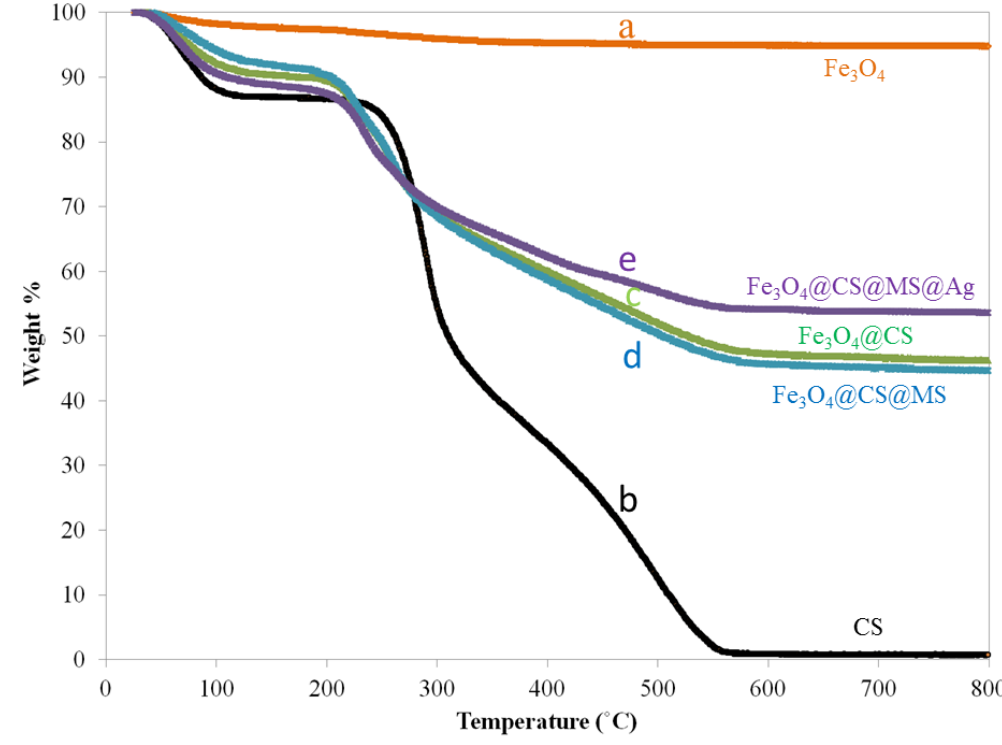
Figure 2. TGA thermogram of ( a ) Fe 3 O 4 ; ( b ) CS; ( c ) Fe 3 O 4 @CS; ( d ) Fe 3 O 4 @CS@MS and ( e ) Fe 3 O 4